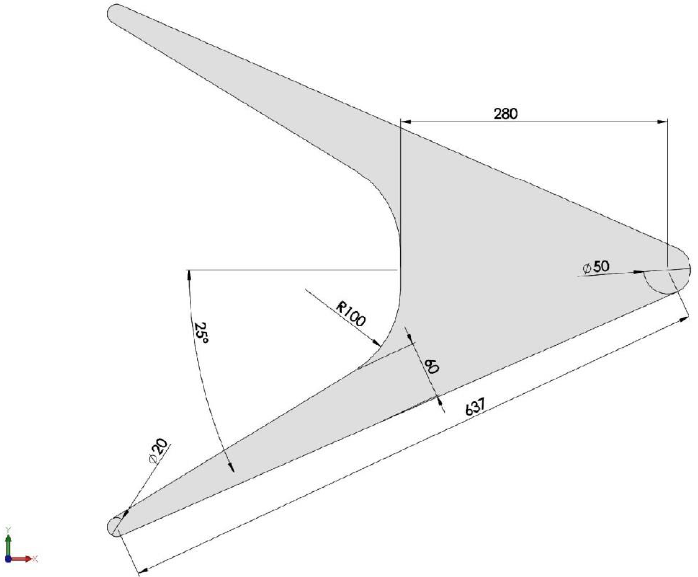
Figure 11. Delta VLFS with stern radius 𝑹 𝟑 = 𝟏𝟎 𝐦 (20 m stern diameter).